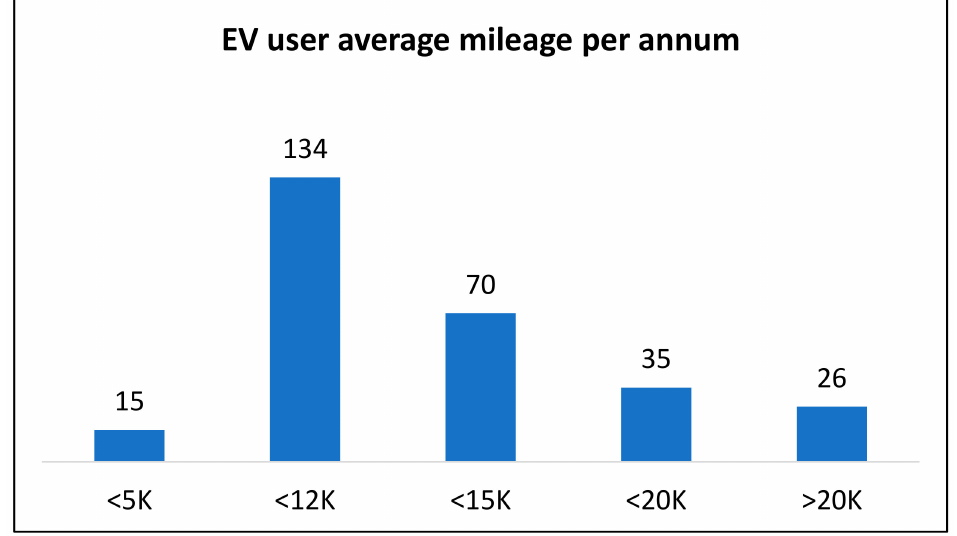
Figure 16. Number of survey responses by mileage